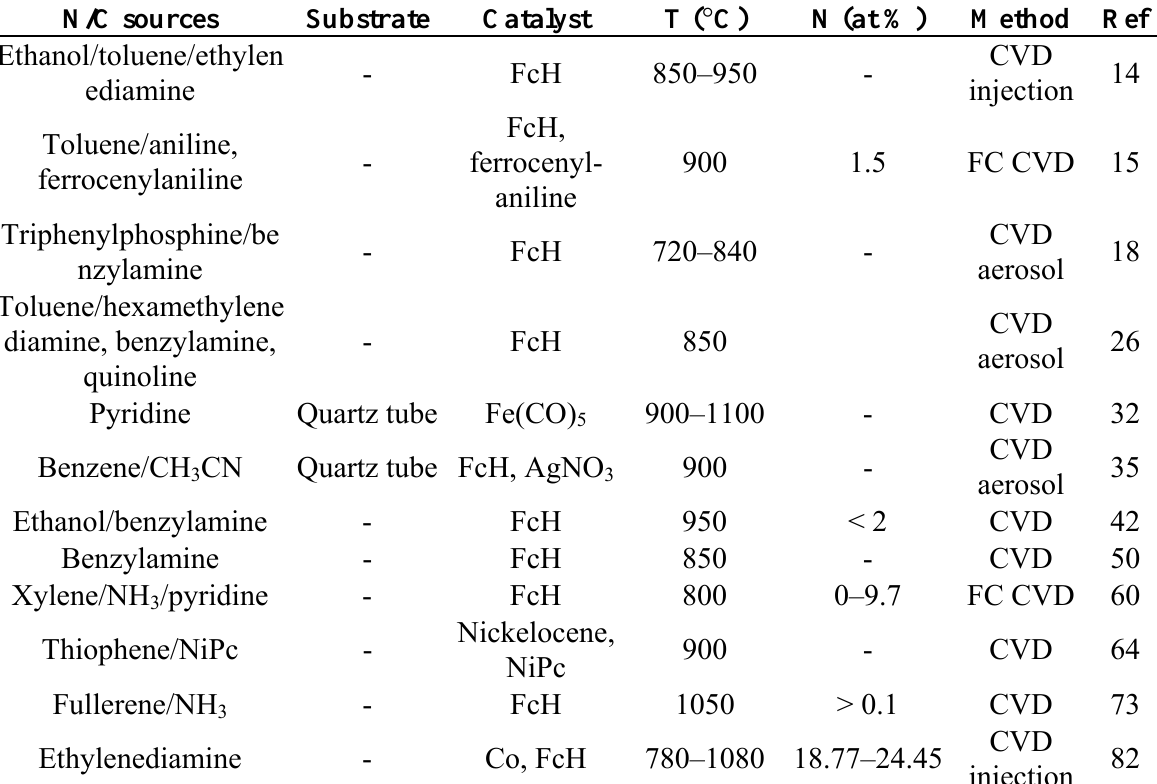
Table 1. Synthesis of N-CNTs using organometallic